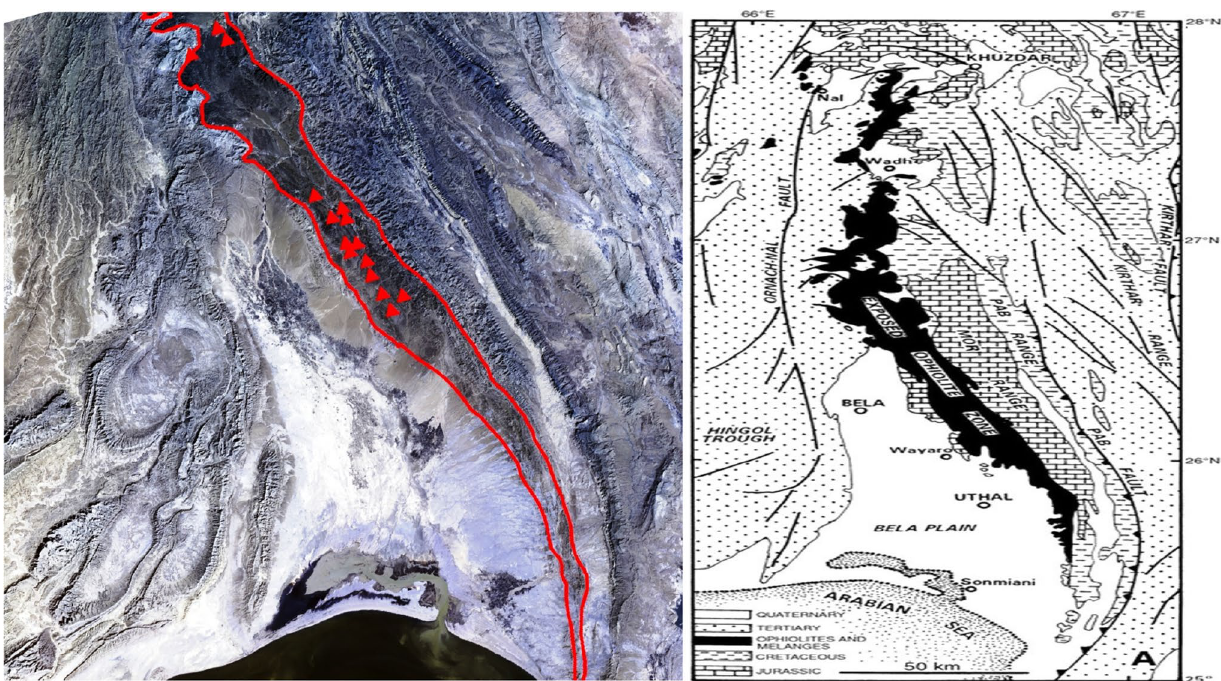
Fig. 1 a Illustration shows the Mn sample locations falling in the Ophiolite of Bela Zone on Landsat image. b Regional Geological Map show- ing Bela ophiolite and surrounding area (after Zaigham and Mallick